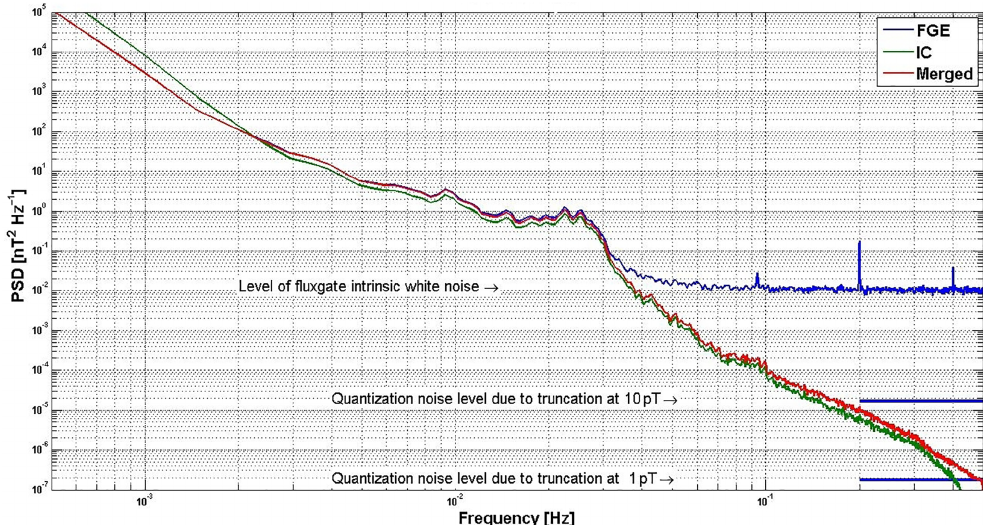
Figure 3. Spectra of unprocessed (FGE) and merged data of the entire day (17 July 2016). The level of the fluxgate-inherent white noise is clearly visible for frequencies over 0.04Hz (blue), whereas the merged data show the continuing decay as expected for the natural field (red).